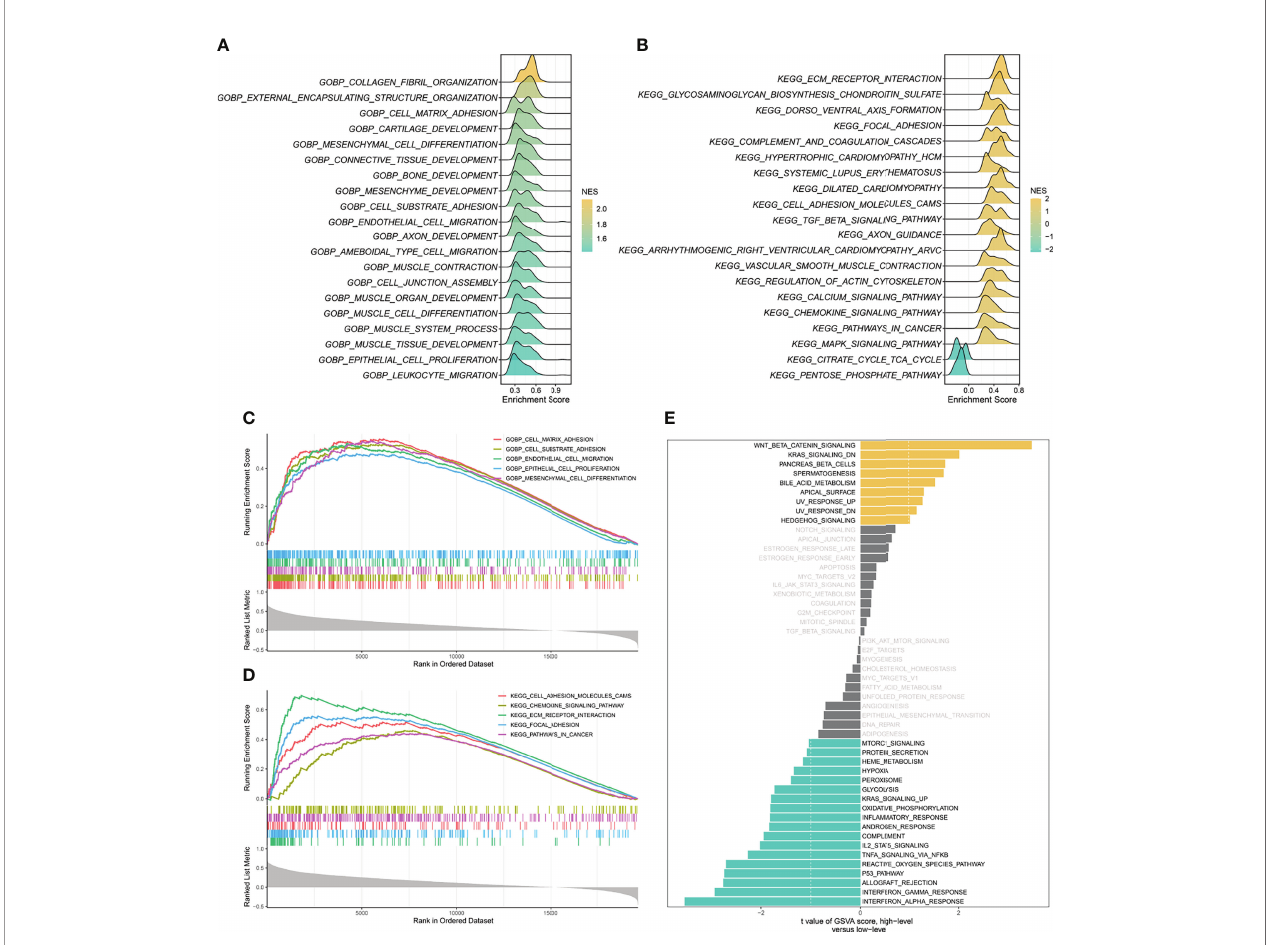
FIGURE 4 | Gene set enrichment analysis (GSEA) and gene set variation analysis (GSVA) of SCG2. (A) Top 20 Gene Ontology (GO) terms with signi fi cant enrichment. (B) Top 20 Kyoto Encyclopedia of Genes and Genomes (KEGG) pathways with signi fi cant enrichment. (C) Five signi fi cantly enriched GO terms associated with SCG2. (D) Five Signi fi cantly enriched KEGG pathways associated with SCG2. (E) Differences in pathway activities scored by GSVA between high and low expression of